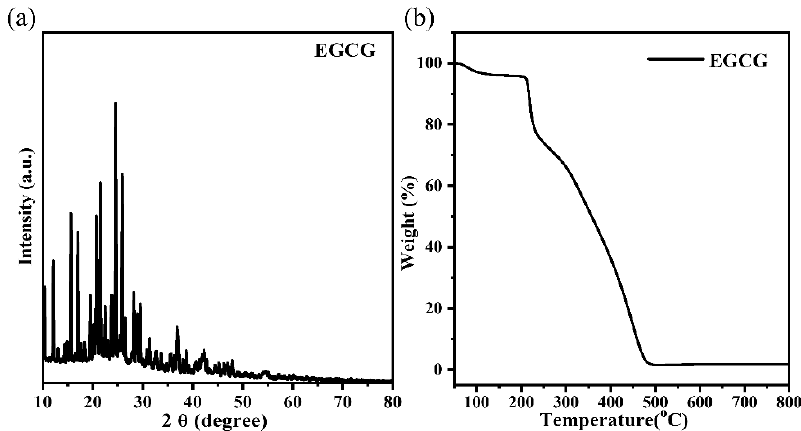
Figure 6. ( a ) XRD patterns of EGCG; ( b ) TGA analysis of